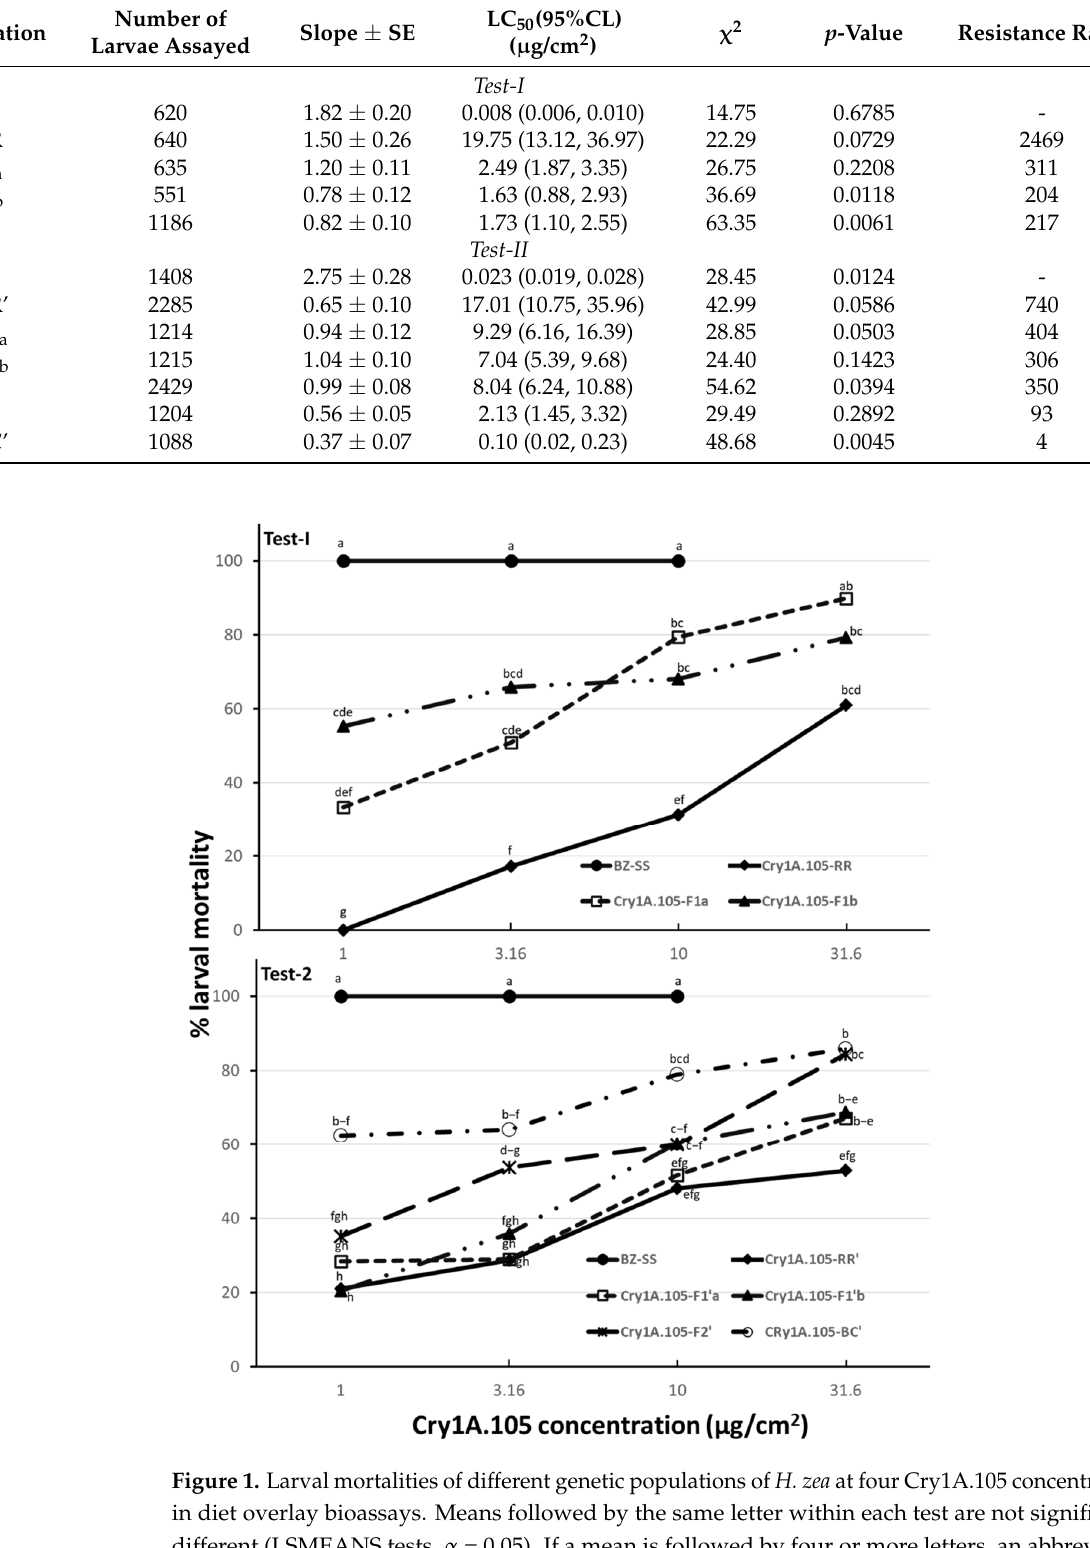
Figure 1. Larval mortalities of different genetic populations of H. zea at four Cry1A.105 concentrations in diet overlay bioassays. Means followed by the same letter within each test are not significantly different (LSMEANS tests, α = 0.05). If a mean is followed by four or more letters, an abbreviation with only the first and last letters is presented; for example, ’b–f’ means ‘bcdef’.